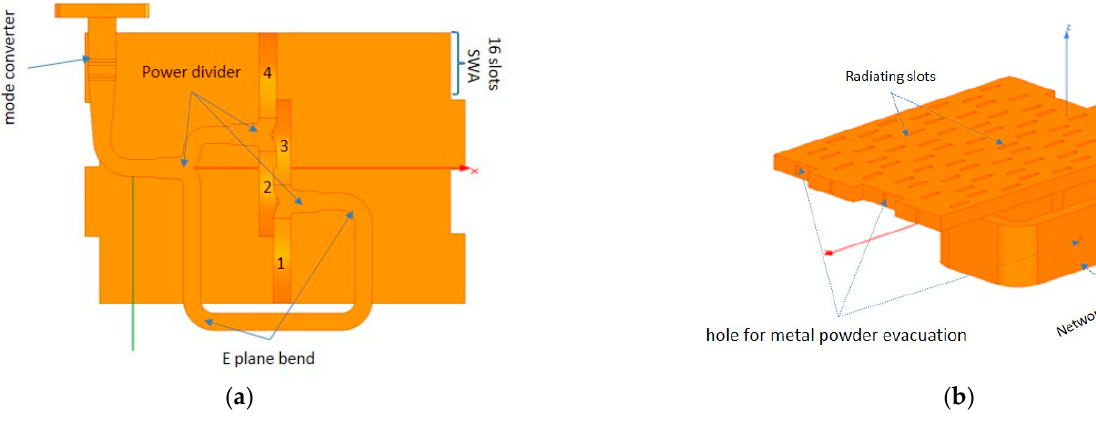
Figure 11. Design of the SWA array. ( a ) Bottom view with the bottom access 1,2,3,4 of the four 16 slots SWA and ( b ) 3D view.